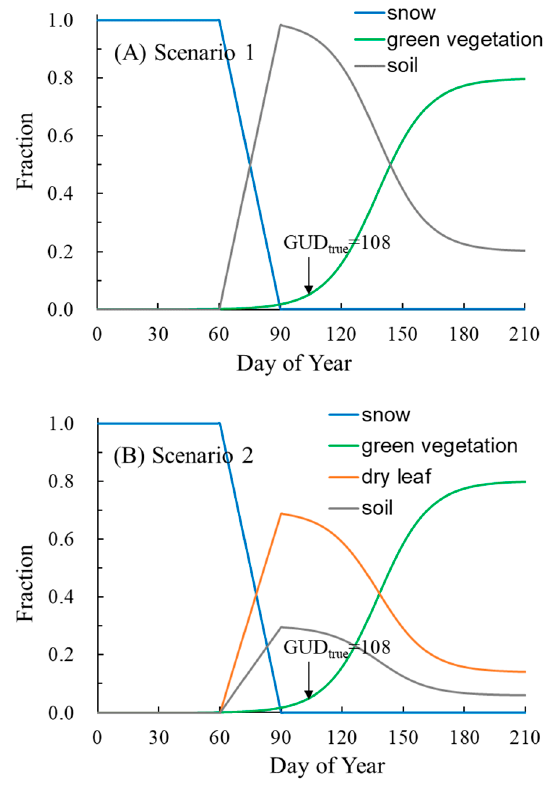
Figure 3. Temporal dynamics of the fraction of different components for ( A ) Scenario 1: snow, green vegetation, and soil, and ( B ) Scenario 2: snow, green vegetation, soil, and dry leaf.